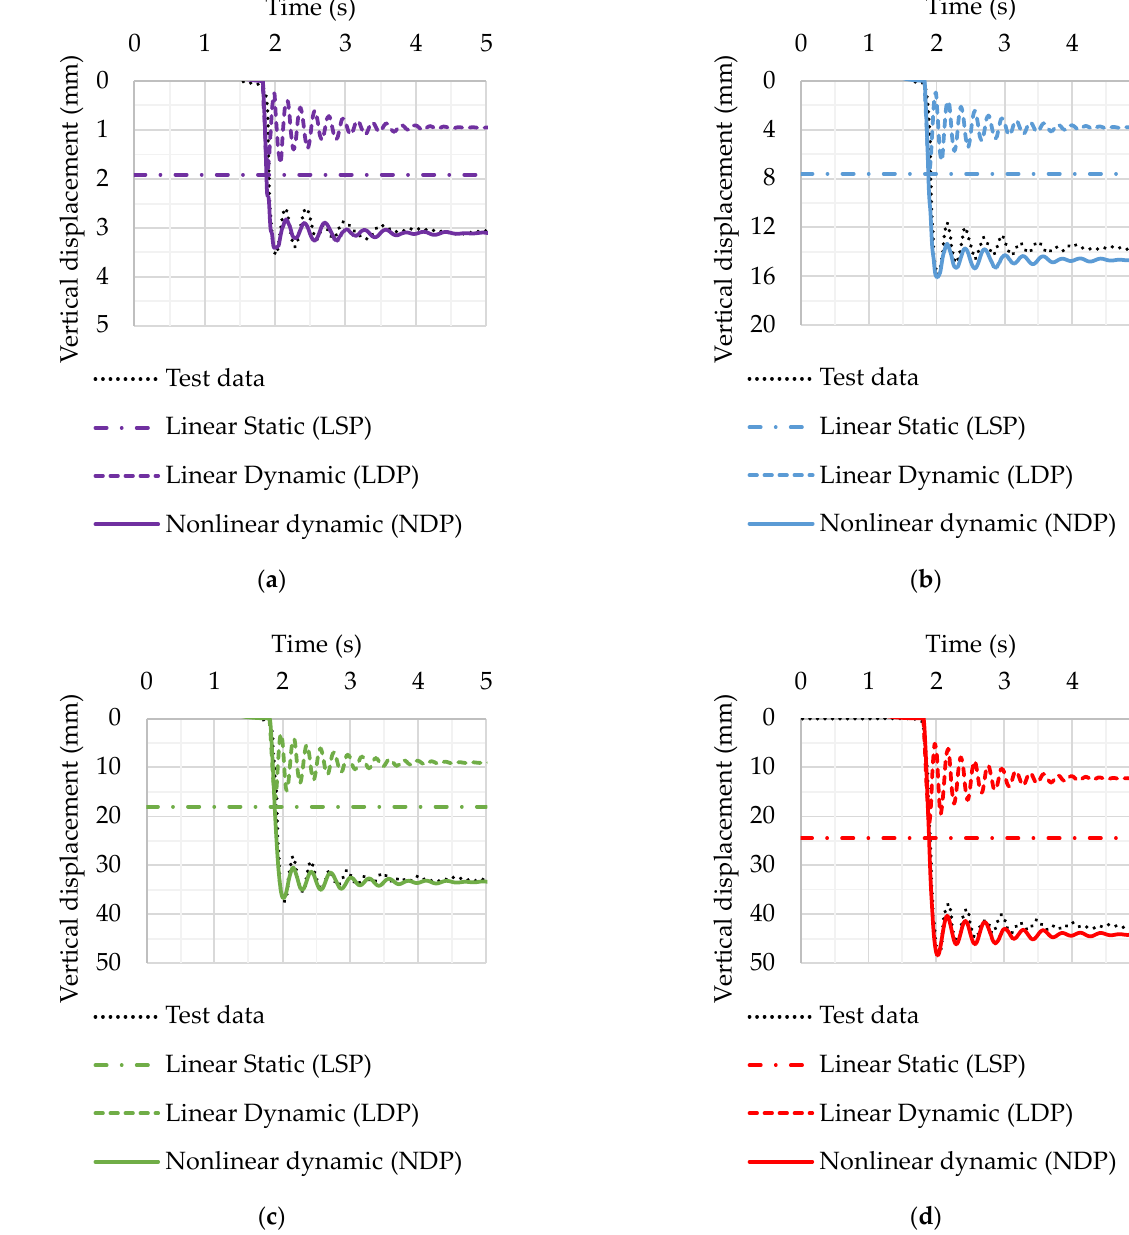
Figure 12. Comparison of vertical displacements obtained from numerical simulations with test data for different points: ( a ) — P2_11V; ( b ) — P23_1/3V; ( c ) — P23_2/3V; ( d ) — P3_11V.